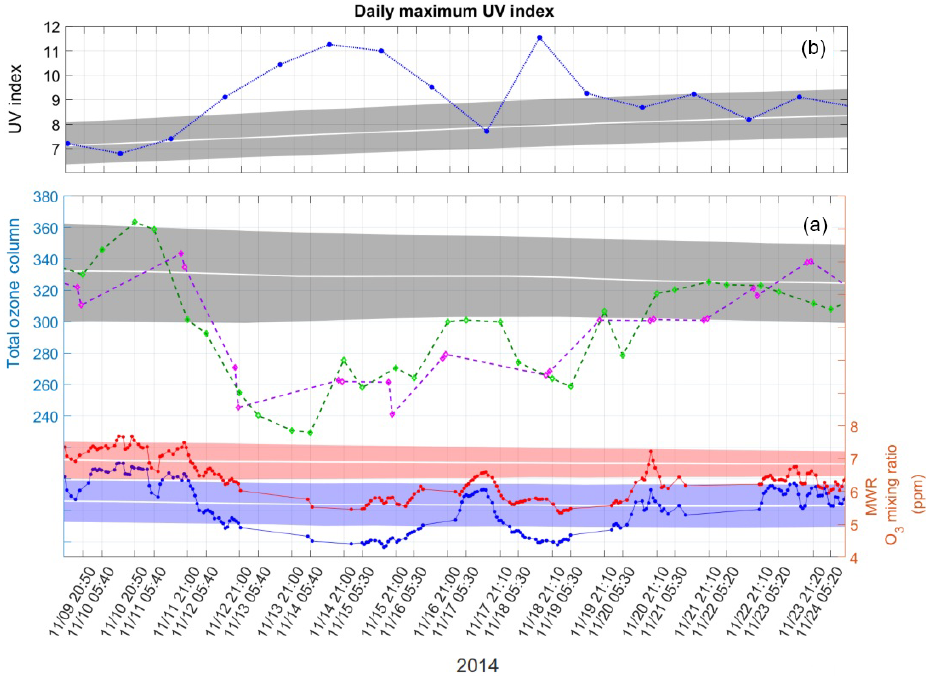
Figure 7. Atypical event of Antarctic ozone hole influence over Río Gallegos. (a) Time evolution of the MWR ozone mixing ratio at 27km (red line) and 37km (blue lines). Light red and light blue areas represent the ozone mixing ratio zonal climatology at both altitudes calculated using the MLS database (2004–2016). (a) Time evolution of the total ozone column measured with the ground-based SAOZ instruments (green dots) and OMI (purple dots) in Dobson units. White line and grey area represent the climatology and 1 SD calculated using the OMI database (2004–2017). (b) Time evolution of the daily maximum Ultraviolet Index measured with the YES UVB-1 ground-based solar radiometer at the OAPA. White line and grey area represent the climatological UVI at noon in Río